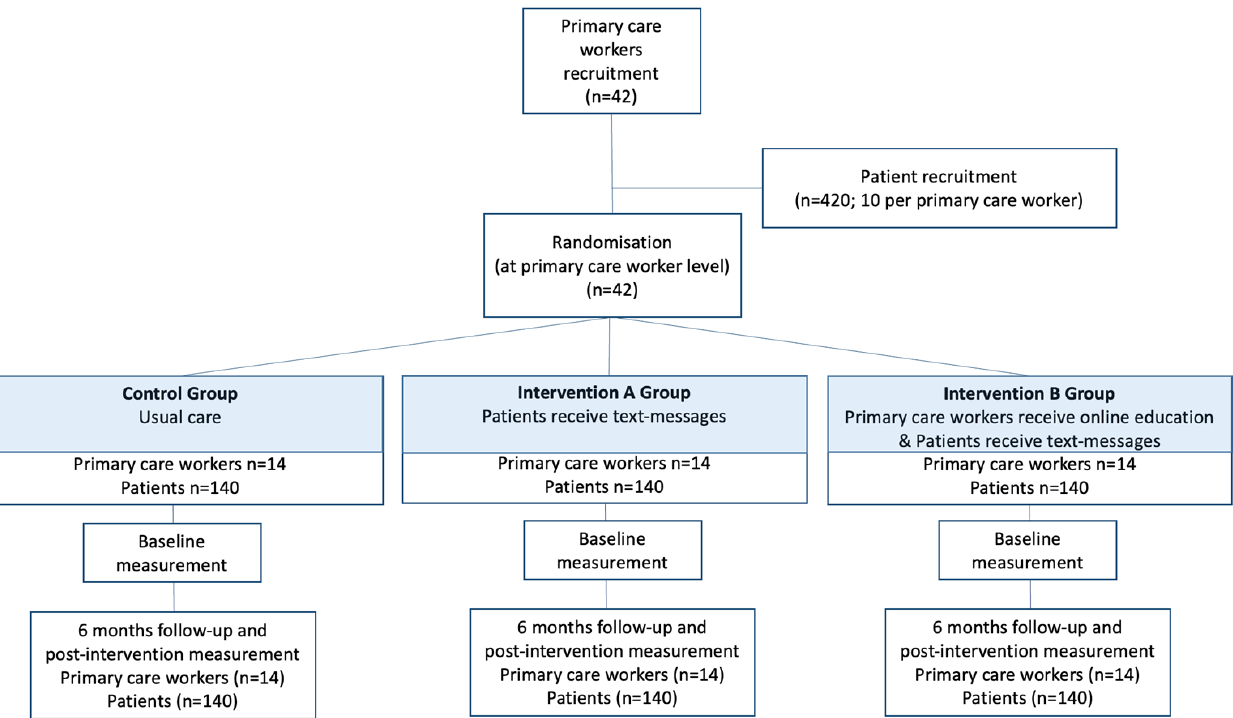
Figure 4. Phase II PreDiabeText study timeline. 2.4. Participants 2.4.1. Primary Healthcare Professionals Selection criteria: We will include GPs and nurses from primary care centres in Mal- lorca that agree to participate. We will exclude those planning to move to a different centre during the study period. Recruitment procedure: We will invite GPs and nurses by email (containing all the relevant information about the study) and a phone call to confirm participation. We will provide participant information sheets and will obtain informed consent (audio recorded over the phone). We will prioritize the recruitment of those primary care professionals with a higher number of patients meeting criteria for prediabetes (detailed below).